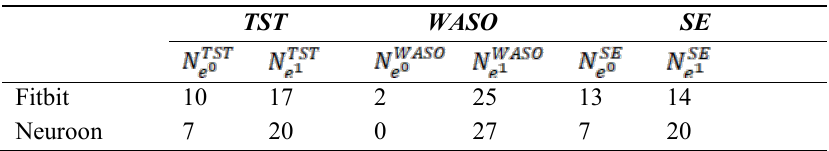
Table 4. The number of observations in